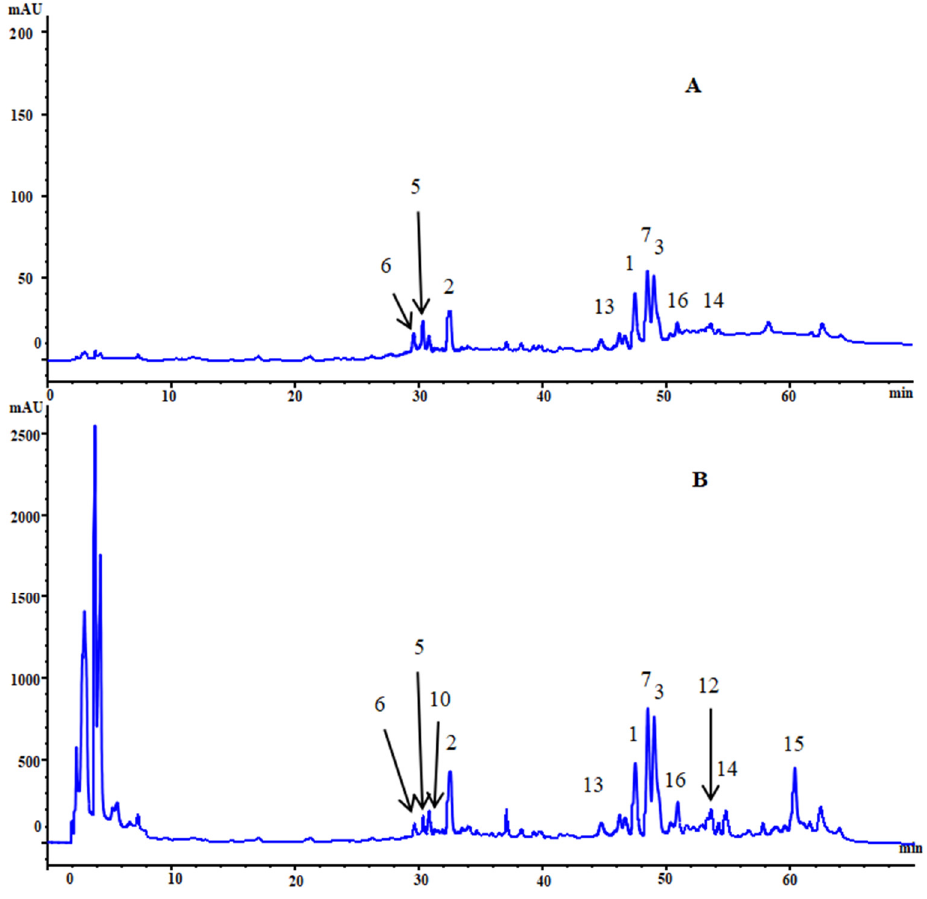
Figure 2. HPLC chromatograms of solution of standards ( A ) and samples ( B ) at 210 nm. Peaks: luteolin ( 1 ), resveratrol ( 2 ), kaempferol ( 3 ), caffeic acid ( 5 ), chlorogenic acid ( 6 ), rutin ( 7 ), 2- β - D -glucopyranosyloxy-1-hydroxytrideca-3,5,7,9,11-pentayne ( 10 ), O- α - D -glucopyranosyl-(1 → 4)- α - D -glucopyranosyl-(1 → 4)- α - D -glucopyranosyl-(1 → 2)- β - D -fructofuranoside ( 12 ), catechin ( 13 ), quercitrin ( 14 ), oleanolic acid ( 15 ) and tyrosol ( 16 ).